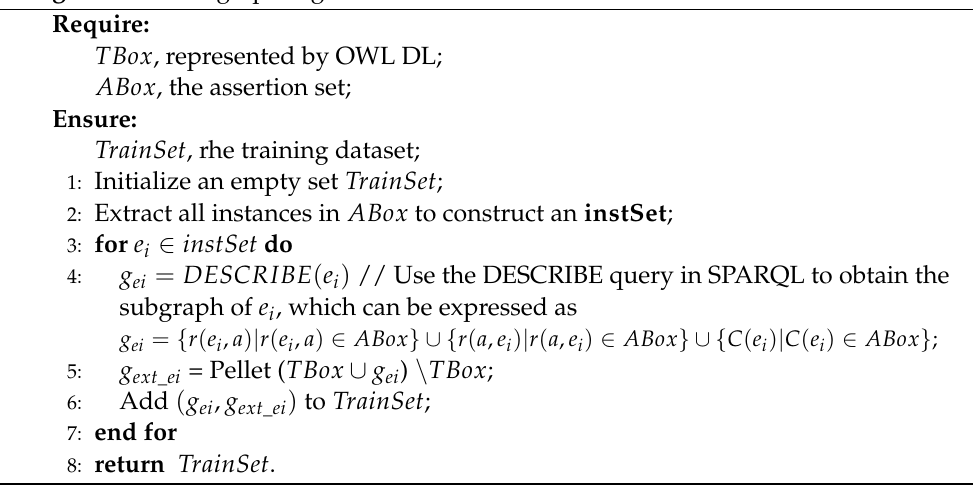
Algorithm 2: Subgraph segmentation and dataset